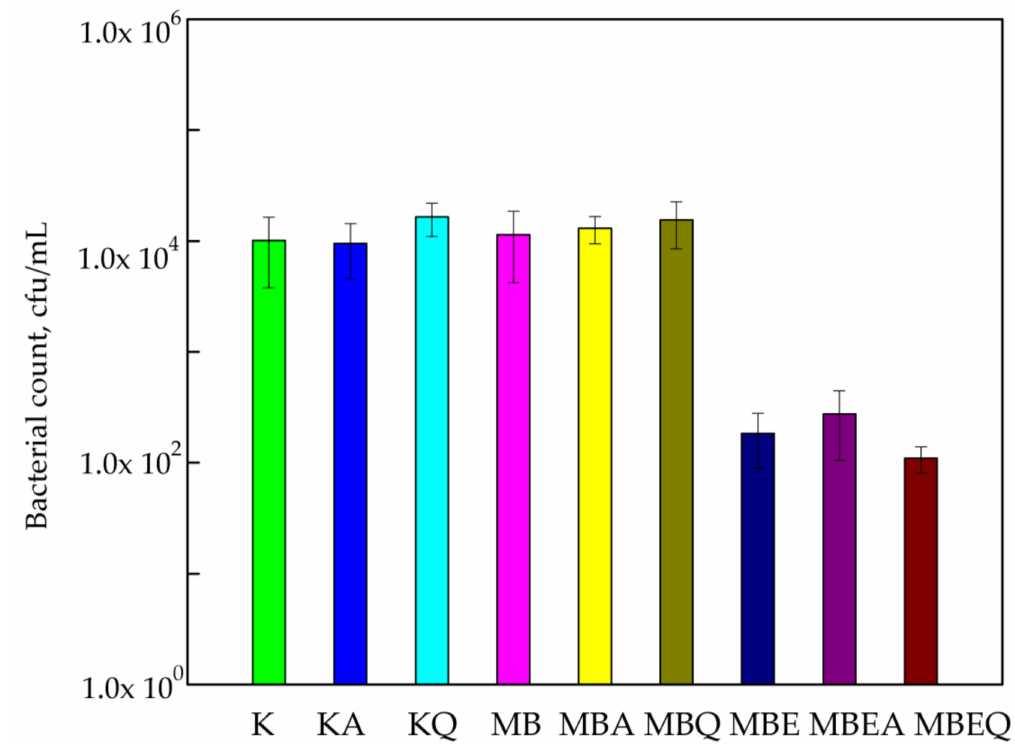
Figure 2. The influence of coatings on B. cereus growth. K—PLA film; KA—UV-A irradiated